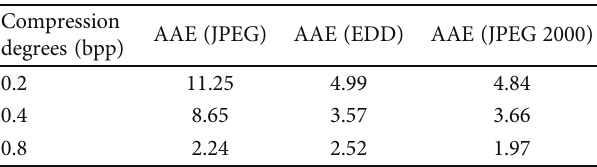
Table 1: The average absolute error value (AAE) for the image with di ff erent degrees of